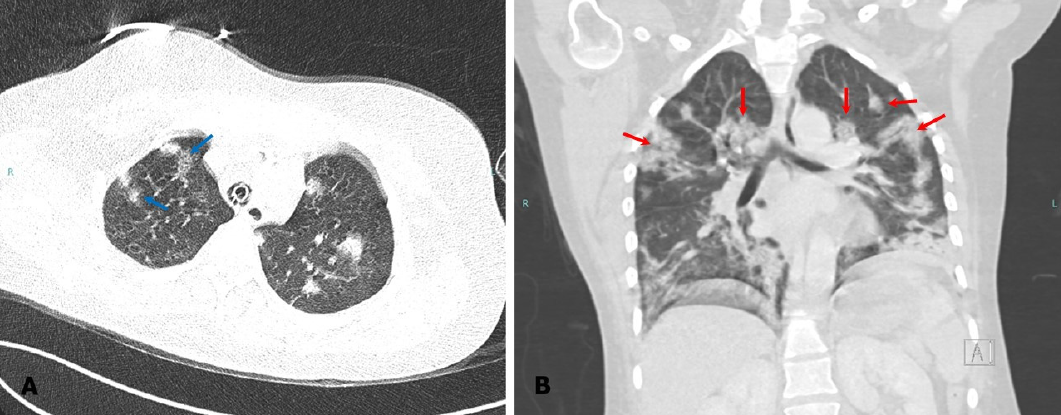
Figure 1. Computed tomography of the chest. The image taken prior to the diagnosis of fungal infection shows consolidation of ground glass opacities (( A ), blue arrow) and bilateral nodular opacities in the upper lobes (( B ), red arrow).